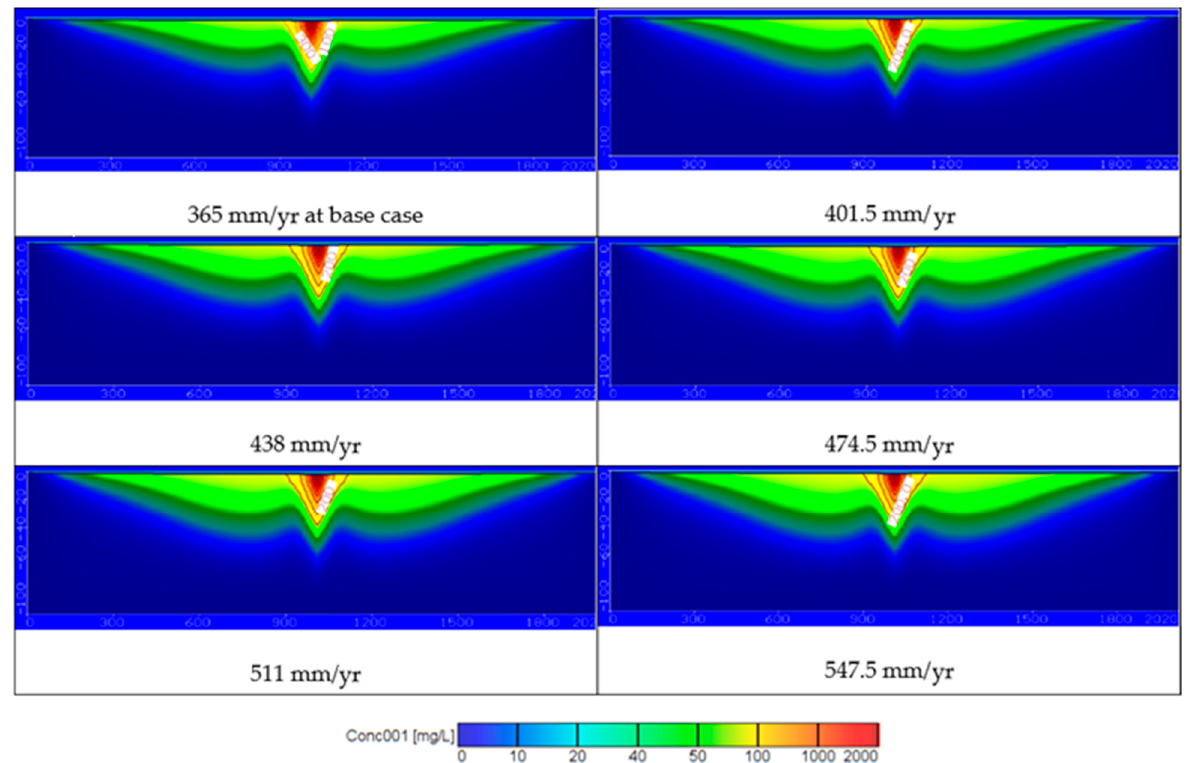
Figure 7. The distribution of COD in groundwater contamination for different wastewater recharge rates.